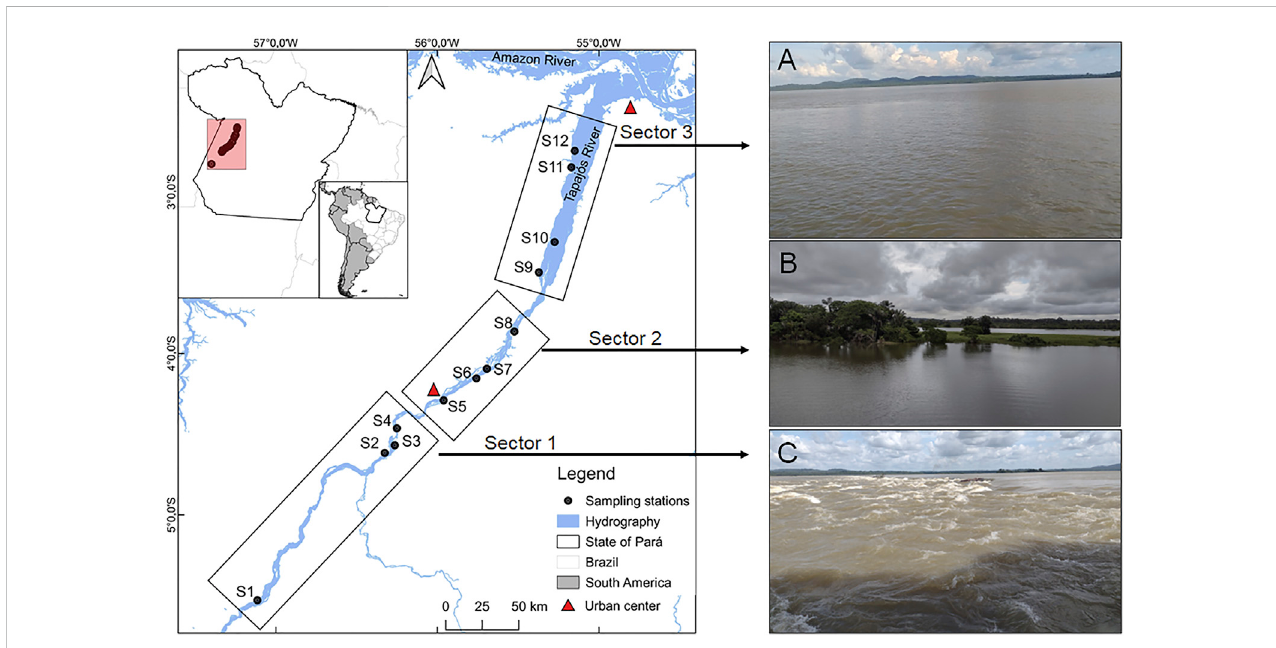
FIGURE 1 Location of the study area with an emphasis on the sampled sectors and collection stations along the middle and lower reaches of the Tapajós River, Amazon Basin, Brazil. (A) : characteristic environment of sector 3. (B) : characteristic environment of sector 2. (C) : characteristic environment of sector